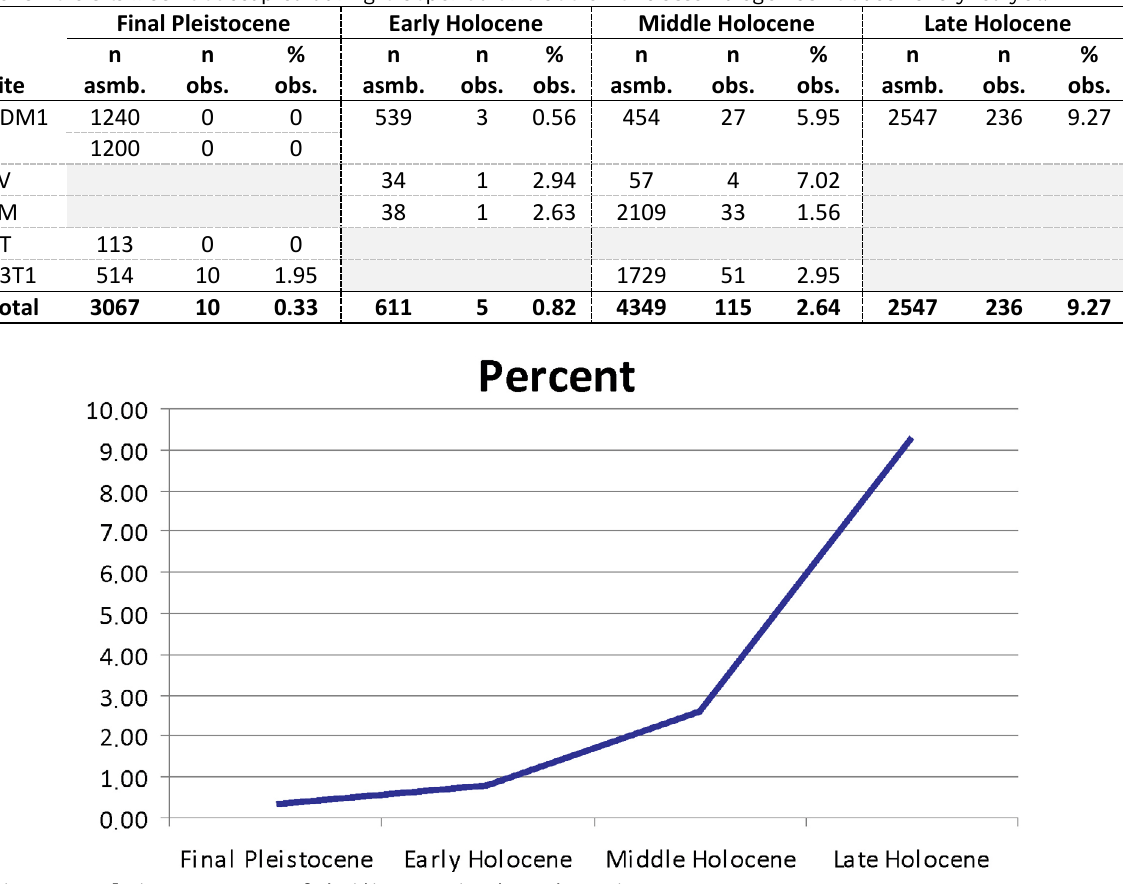
Figure 3. Relative percentage of obsidian remains throughout